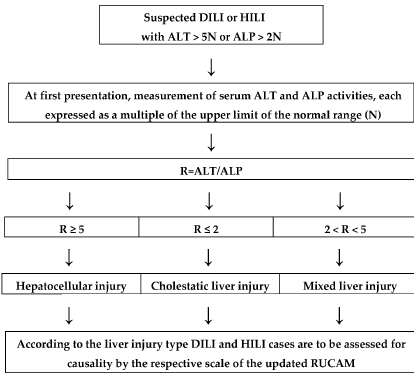
Figure 1. Classification of liver injury required for causality assessment of suspected DILI and HILI cases by the updated RUCAM. Note above: ALP from hepatic origin only. Abbreviations: ALP, alkaline phosphatase; ALT, Alanine aminotransferase; DILI, Drug-induced liver injury; HILI, Herb-induced liver injury; N, Upper limit of normal; R, Ratio; RUCAM, Roussel Uclaf Causality Assessment Method. Table 1. Specific operational information on the updated